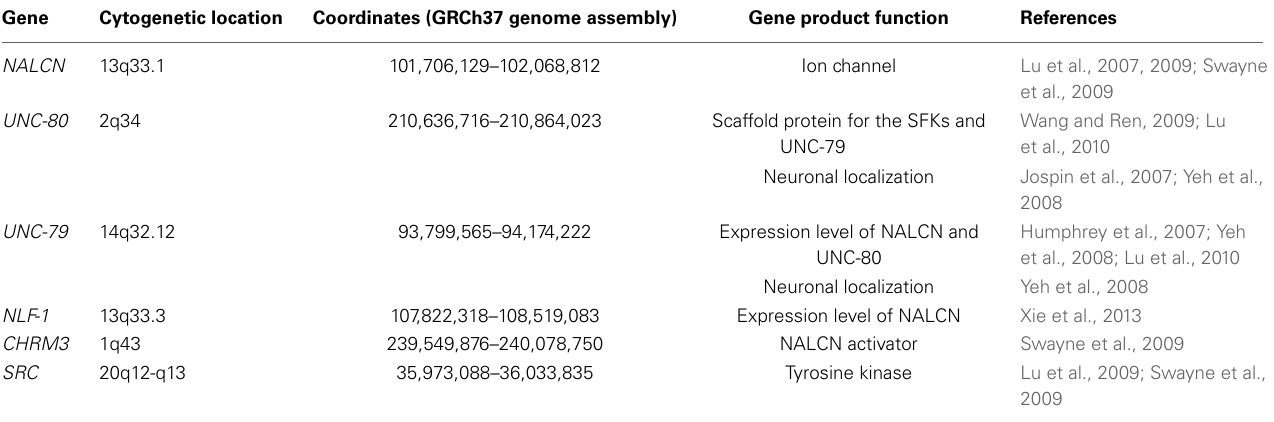
Table 1 | Genes involved in the NALCN channelosome and their known roles.